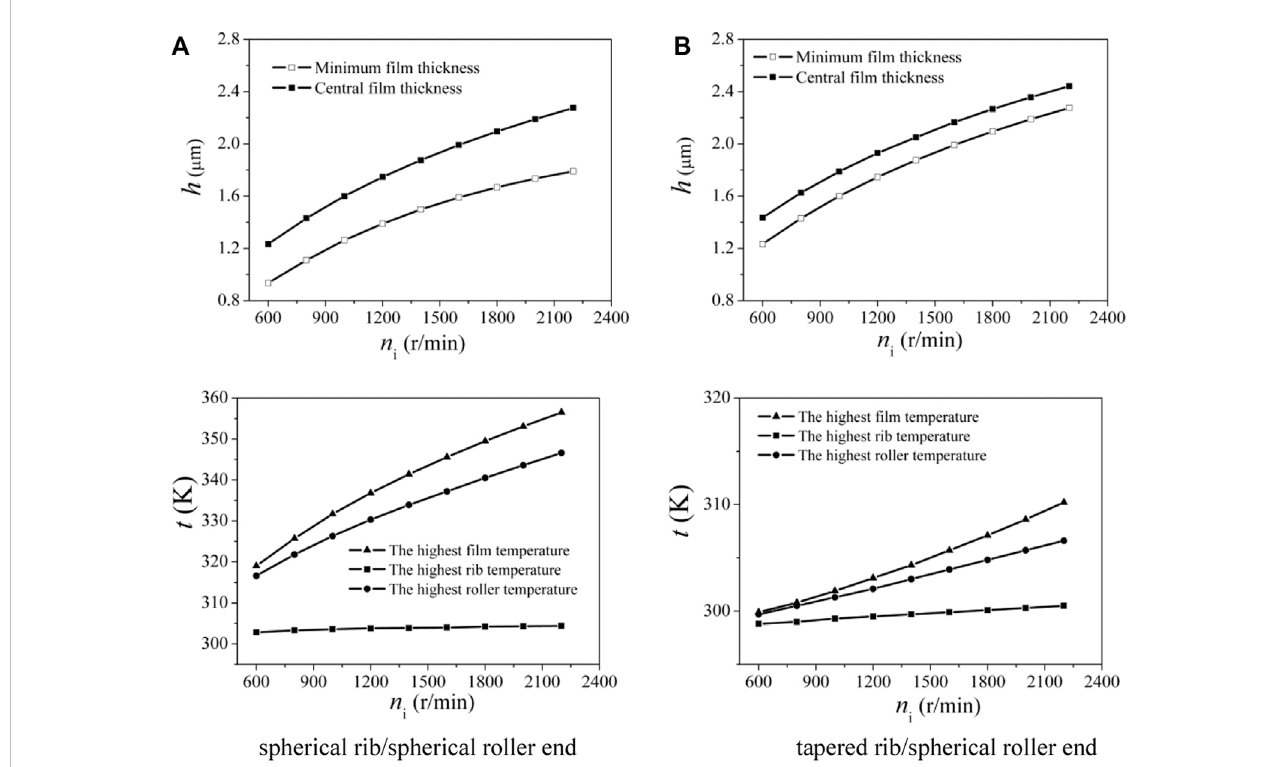
FIGURE 6 Effectofrotatingspeedson fi lmthicknessandtemperatureoftworibstructuresfor R x 2 / R x 1 =0.7and w =320 N. (A) Sphericalrib/sphericalrollerend; (B) tapered rib/spherical roller